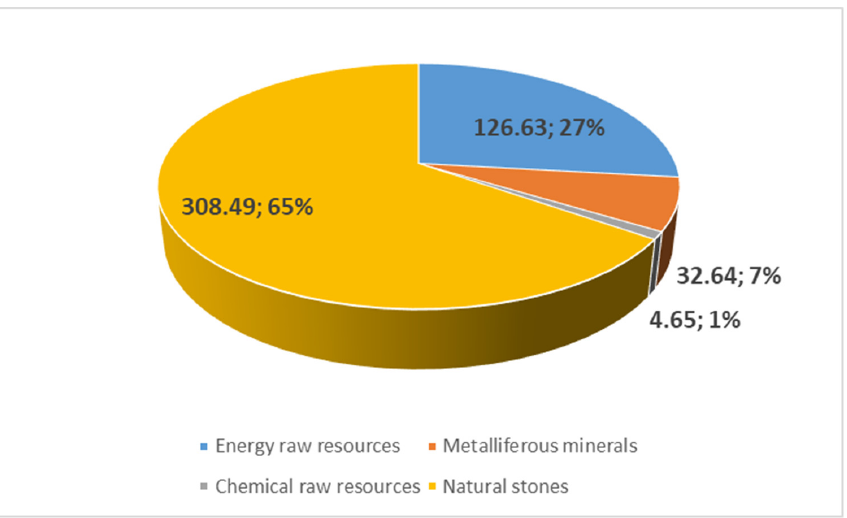
Figure 2. Average volume of extraction of energy minerals in Poland for the period 2014–2020. Authors’ own study based on [21–27].